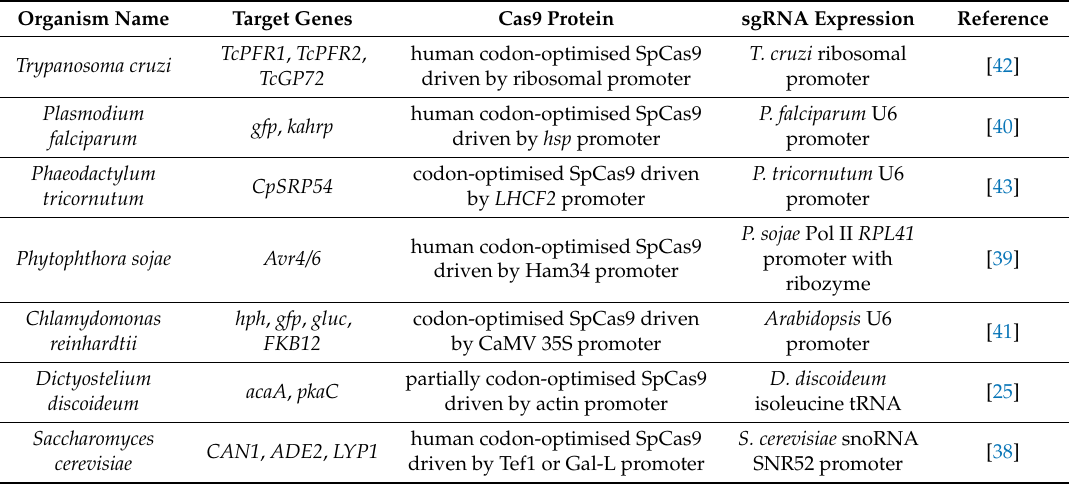
Table 1. Delivery system for CRISPR/Cas9-mediated genome editing in